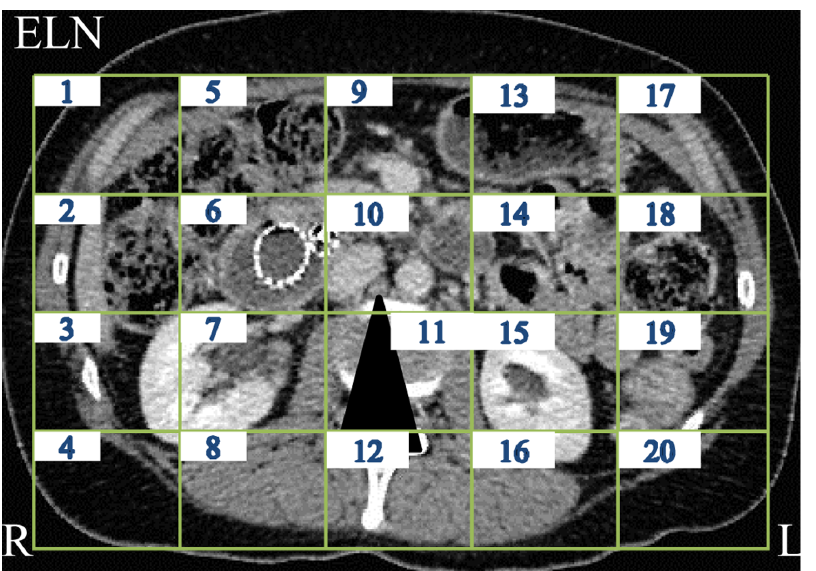
Figure 2. Cross-sectional abdominal CT-image with an ELN divided into 20 equal-sized areas of interest (AOIs). The enlarged lymph node in this image is pointed out by the black arrowhead and resides in Area 10, the area where most lymph nodes are located in all images across videos.